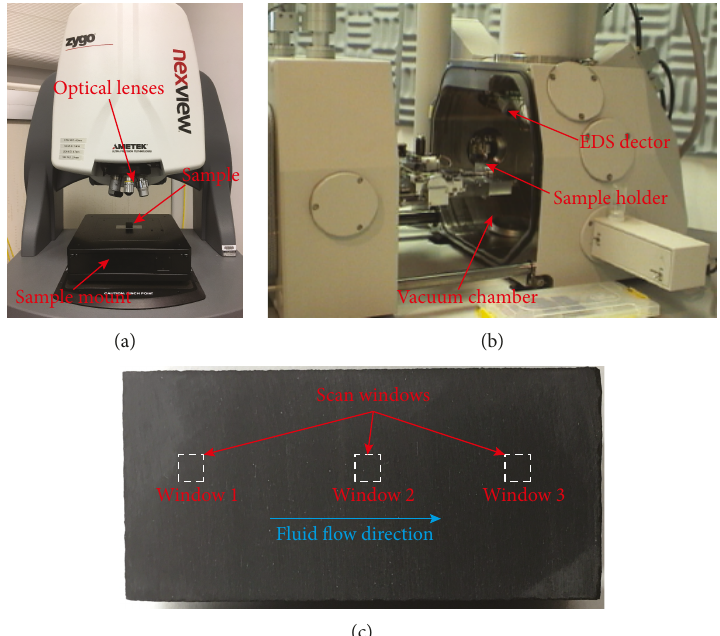
Figure 3: (a) Optical pro fi lometry used in experiment, (b) SEM apparatus used in experiments, and (c) pro fi lometry and SEM scan area before and after core fl ooding tests. The dimension of each window is 1.8mm ×